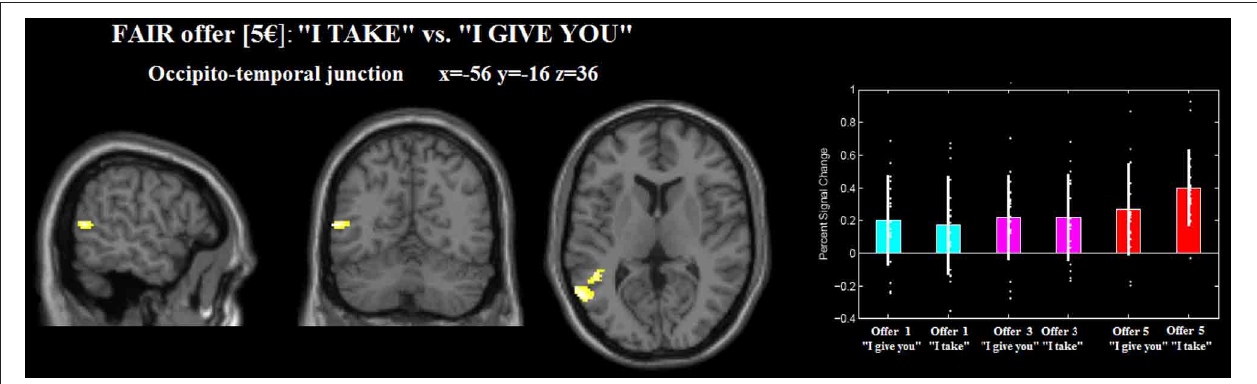
FIGURE 4 | Occipito-temporal junction differentially recruited by gain 5€_“I take” (relative to 5€_“I give you”). The plot were created by using rfxplot [ http://rfxplot . sourceforge . net/ , (Glascher,